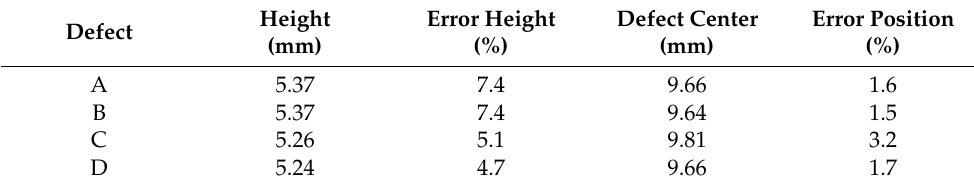
Table 3. Defect height, center position, and related errors using TOFD.